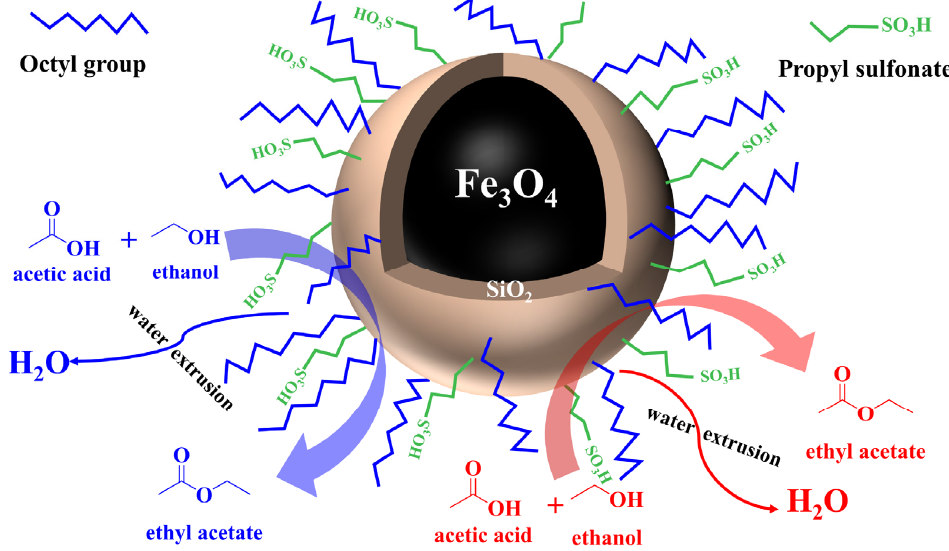
Figure 12. The reaction process of esterification on the surface of catalyst Fe 3 O 4 @SiO 2 -Oc&PrSO 3